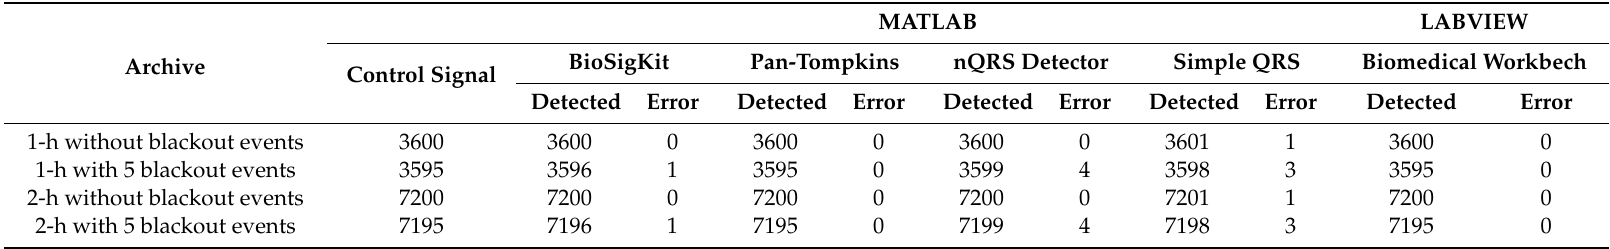
Table 7. Software and algorithm evaluation for automatic ECG signal analysis. The control signal is created with a specific number of QRS